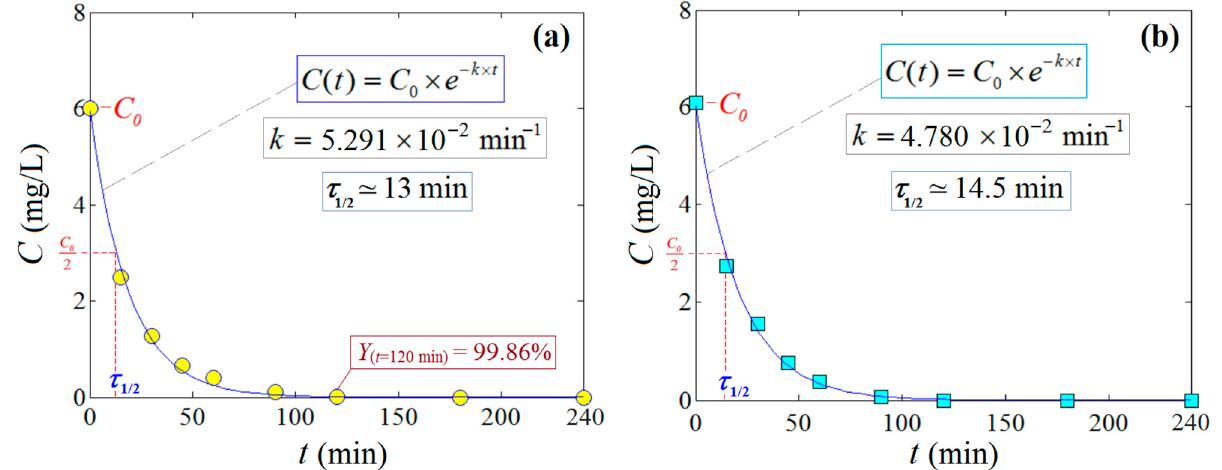
Figure 10. Kinetics profile of photocatalytic degradation (by visible light irradiation) of the CIP pollutant ( a ) and MB dye ( b ) determined under optimal conditions ( C 0 = 6.0 mg/L and CatDose = 0.20% w / v ) in the presence of the most efficient catalyst, ZnO:Nd (0.1%). Additionally, we found that ciprofloxacin was degraded by about 59% under UV light irradiation without a catalyst (photolysis), compared to only 14% in visible light (Figure S1, Supplementary Materials). Therefore, this study pointed out the degradation of both pollutants in mild environmental conditions, involving no acidification of solutions and/or the absence of H 2 O 2 , usually used to boost the photochemical reactions, and using a visible light source. The stability and reusability of the materials with the best photocatalytic performance (ZnO:Nd(0.1%) material) were evaluated for five reuse cycles, according to Figure 11. For all measurements, the experimental conditions and parameters were kept constant. After each use, the photocatalyst was recovered and dried at 80 °C for 12 h and then used for the next cycle. As can be seen from Figure 11, the photocatalytic performances of the material were relevant even after five cycles of use, which confirmed the superior stability of the newly prepared catalyst. Good stability of the ZnO:Nd (0.1%) material was also obtained for the MB degradation (see Figure S2, Supplementary Materials).